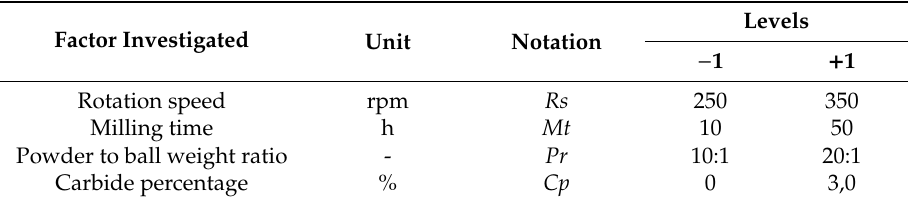
Table 1. Milling parameters and their levels Levels Factor Investigated Unit Notation − 1 + 1 Rotation speed rpm Rs 250 350 Milling time h Mt 10 50 Powder to ball weight ratio - Pr 10:1 20:1 Carbide percentage % Cp 0